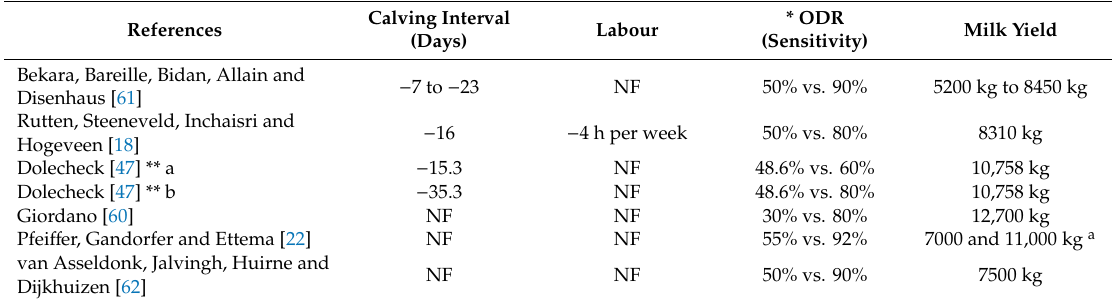
Table 2. E ff ect of Investment in AOD Technologies on Dairy Production performance.